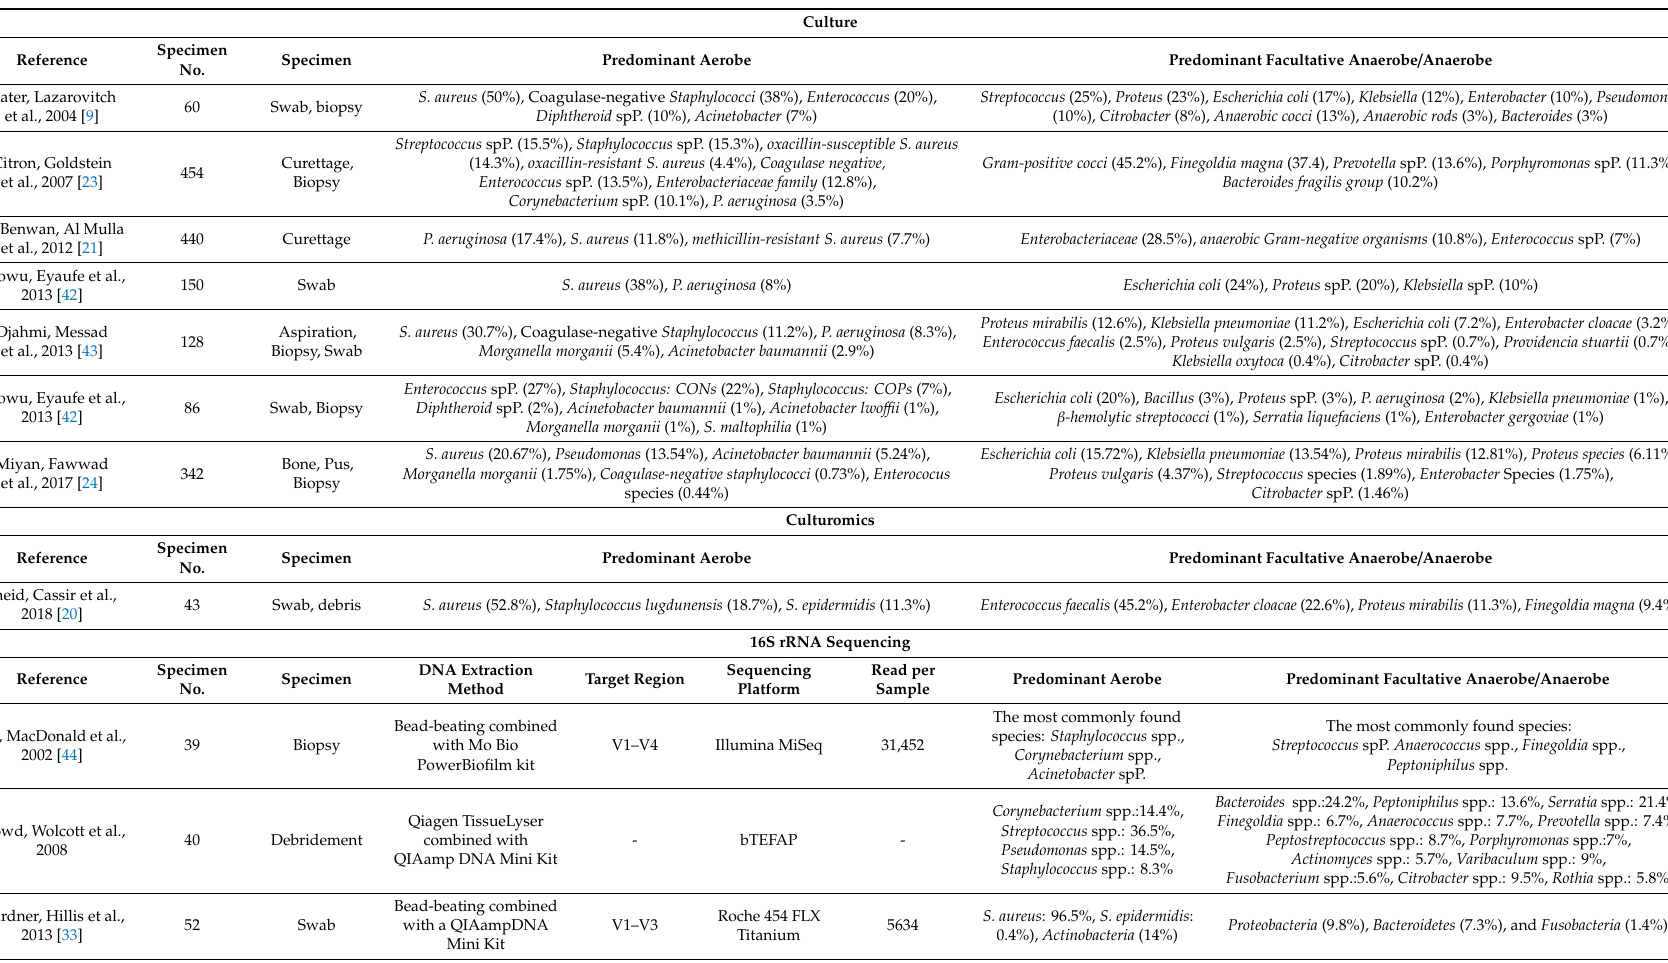
Table 1. Common bacterial species isolated from diabetic ulcers using di ff erent bacterial identification